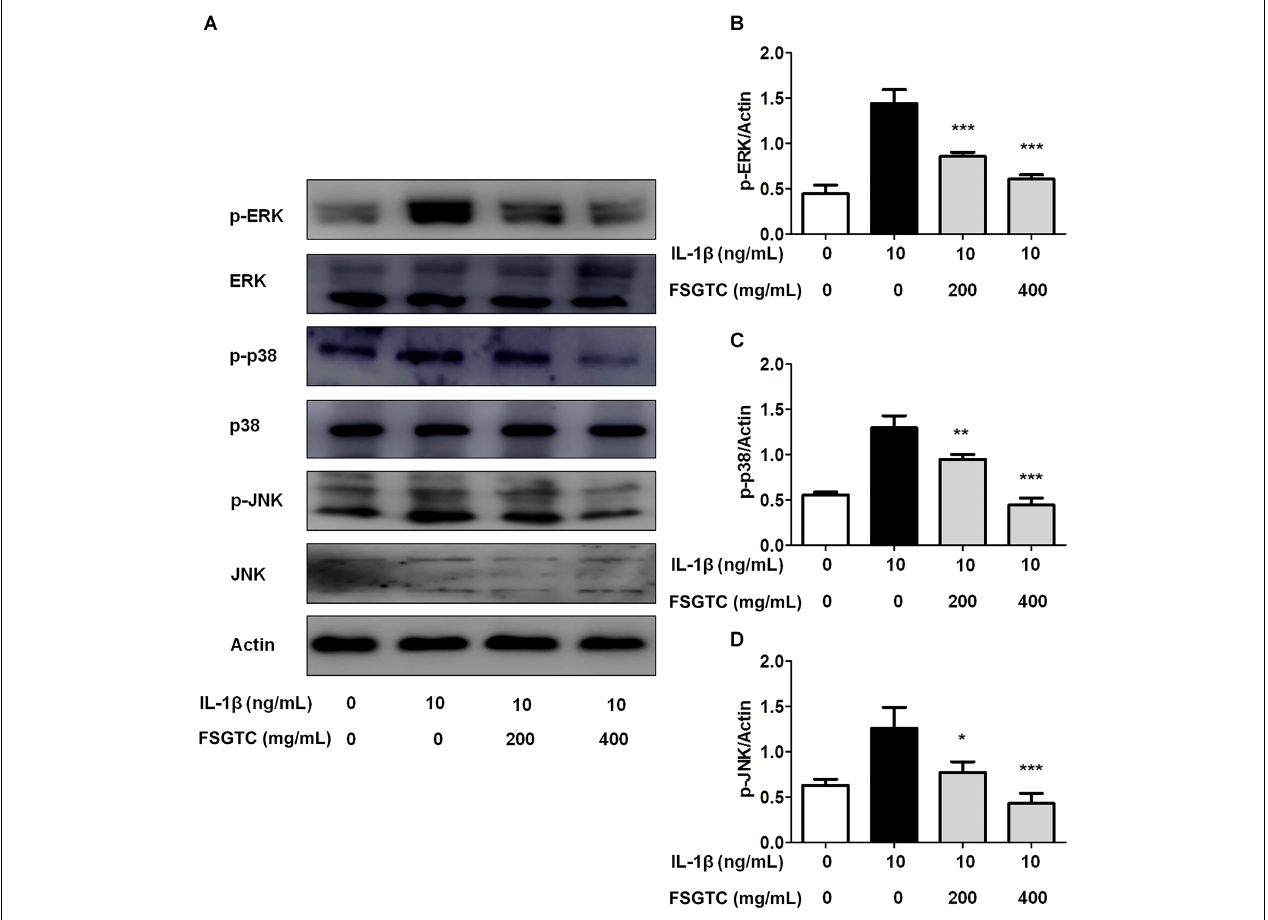
FIGURE 5 | Effects of FSGTC on IL-1 β -induced phosphorylation of ERK, p38, and JNK in SW982 cells. The cells were treated with various doses (200 and 400 mg/mL) of FSGTC. Lysates were prepared and Western blot performed using specific phospho-ERK, phospho-p38, and phospho-JNK antibodies (A) . Histogram analysis for the expression levels of p-ERK (B) , p-p38 (C) , and p-JNK (D) as described above. Actin was used as an internal control. n = 3, x ± s . ∗ p < 0.05; ∗∗ p < 0.01, ∗∗∗ p < 0.001 vs. IL-1 β without